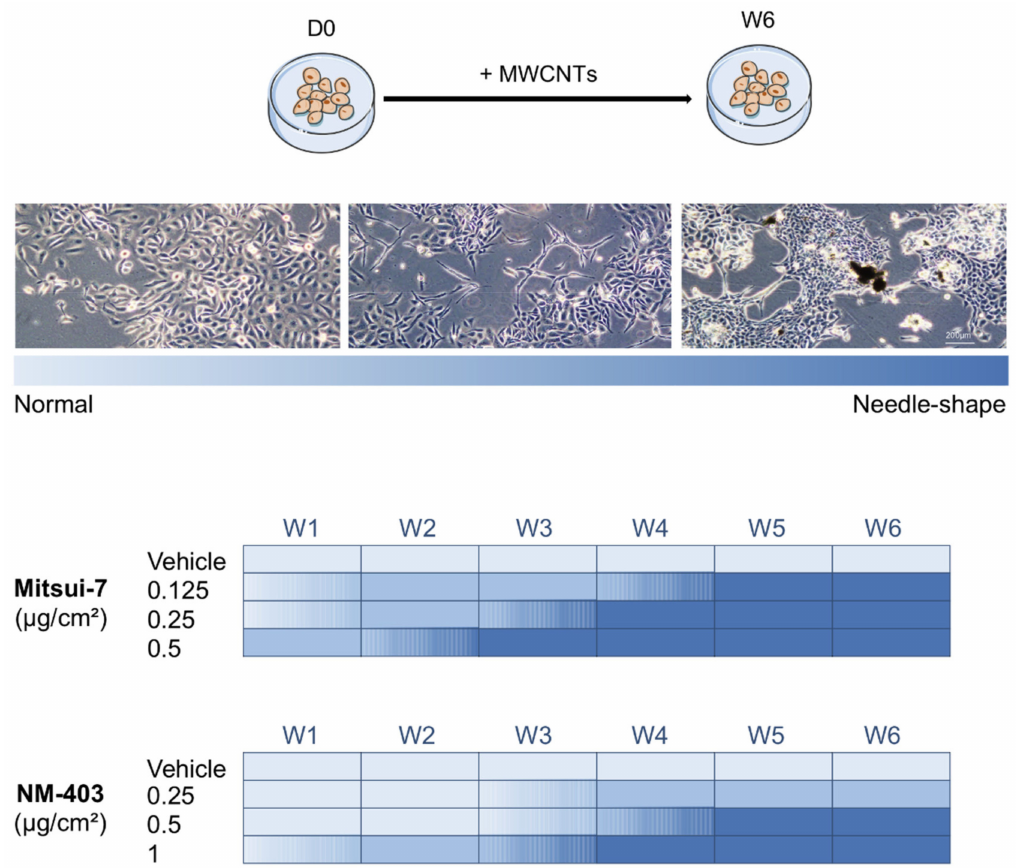
Figure 5. Morphological changes of BEAS-2B cells induced by Mitsui-7 and NM-403. The cells were treated with Mitsui-7 (0.125, 0.25 and 0.5 µ g/cm 2 ) or NM-403 (0.25, 0.5 and 1 µ g/cm 2 ) for 6 weeks. Cell morphology was observed weekly with an optical microscope at the 10 × objective. Representative pictures of morphological changes are presented from normal to needle-shaped cells (upper panel). The heatmap represents the morphological changes, light blue for cells with a normal shape to dark blue for cells with a needle shape (lower panel). The results are representative of at least three independent experiments. W: